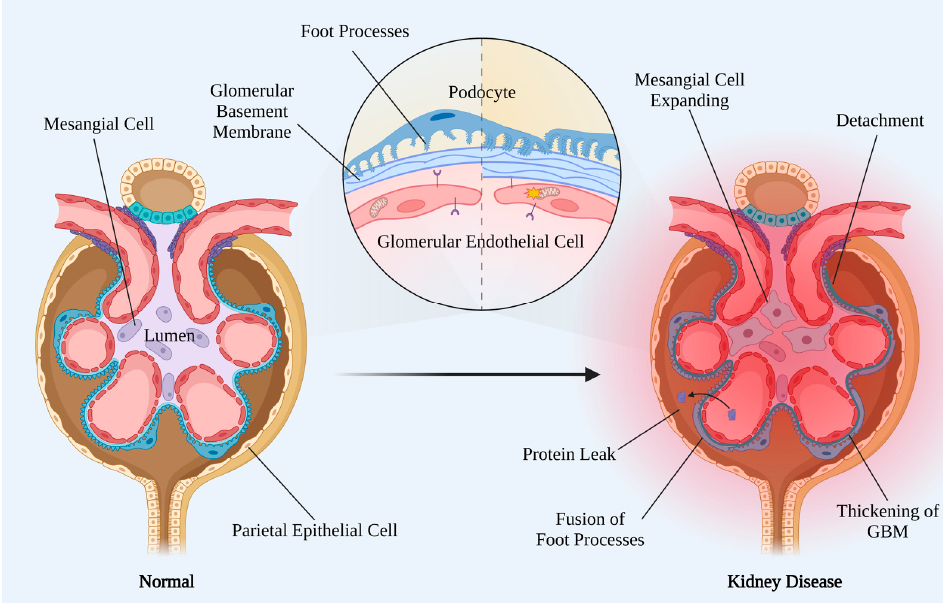
Figure 2. Features of normal and DKD glomerular filtration barriers. The FPs and fenestrated GECs are attached to the GBM, comprising a glomerular filtration barrier. In DKD, the glomerulus undergoes profound morphological changes, including thickening of the GBM and mesangial matrix expansion, occluding its capillaries with the extracellular matrix. Moreover, hemodynamic and metabolic milieu changes lead to FP fusion, podocyte detachment, GEC dysfunction, and the ensuing protein leakage thereof. FP: foot processes; GBM: glomerular basement membrane; GEC: glomerular endothelial cell; MC: mesangial cell; PEC: parietal epithelial cell.